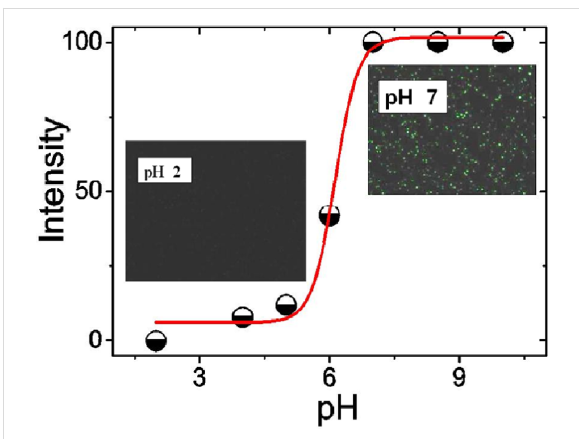
Figure 8: Fluorescence intensity of P(AA- co -FA)-functionalized BNNTs in solution under different pH conditions. The fluorescence in- tensity was measured in distilled water and the pH was adjusted by adding HCl or NaOH. The P(AA- co -FA)-functionalized BNNT concen- tration in the solution was (1 mg/mL). The images demonstrate the fluorescence intensity in the dry state at different pH values recorded by LSCM. Excitation wavelength – 490 nm, emission wavelength – 520